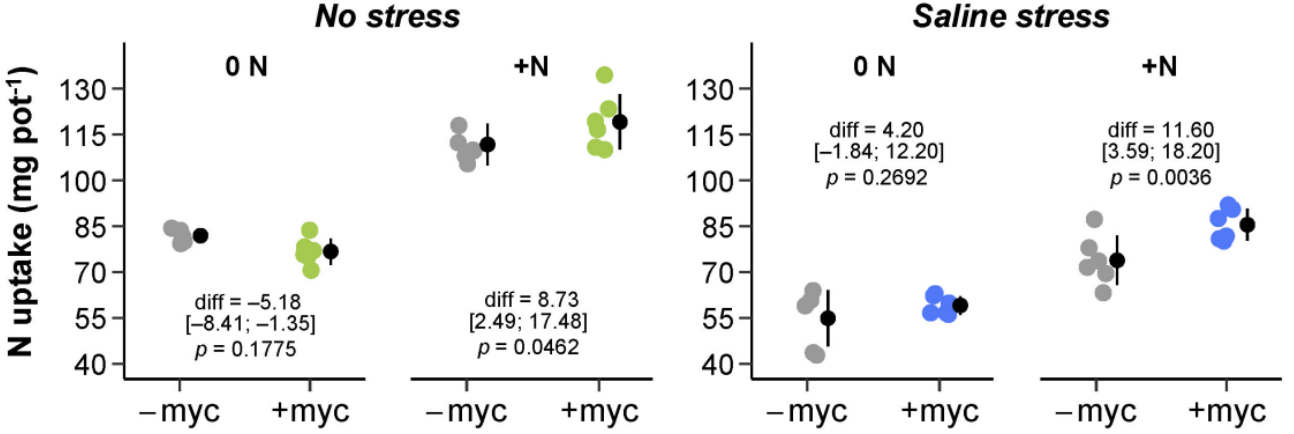
Figure 5. N uptake (mg N per pot) of durum wheat to varying treatments: no-stress or saline stress condition; N fertilization treatments (0 N, +N); absence or presence of arbuscular mycorrhizal fungal inoculum ( − myc, +myc). Black circles represent means, with whiskers representing ± SE ( n = 6). Differences (diff) between +myc and − myc means within the same fertilization treatment and the same saline treatment, estimated 95% confidence intervals of mean difference (in brackets), and p values are reported inside the plots.